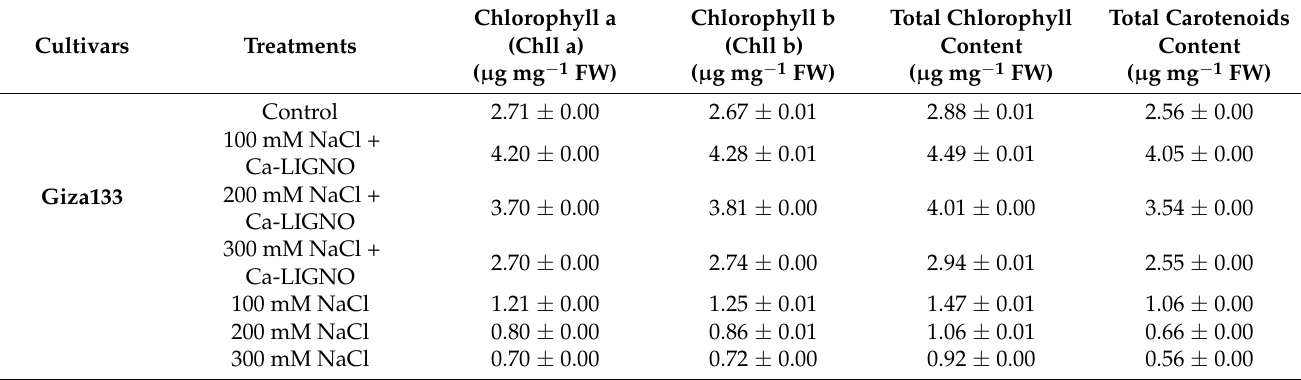
Table 5. Different pigments’ concentrations (chlorophyll a, chlorophyll b, total chlorophyll content, total carotenoids) in the leaf tissues of Giza133 and Giza132 barley cultivars under various treatments (control, NaCl concentrations, and NaCl concentrations + Ca-LIGNO) during two seasons, 2019/2020 and 2020/2021, in combined